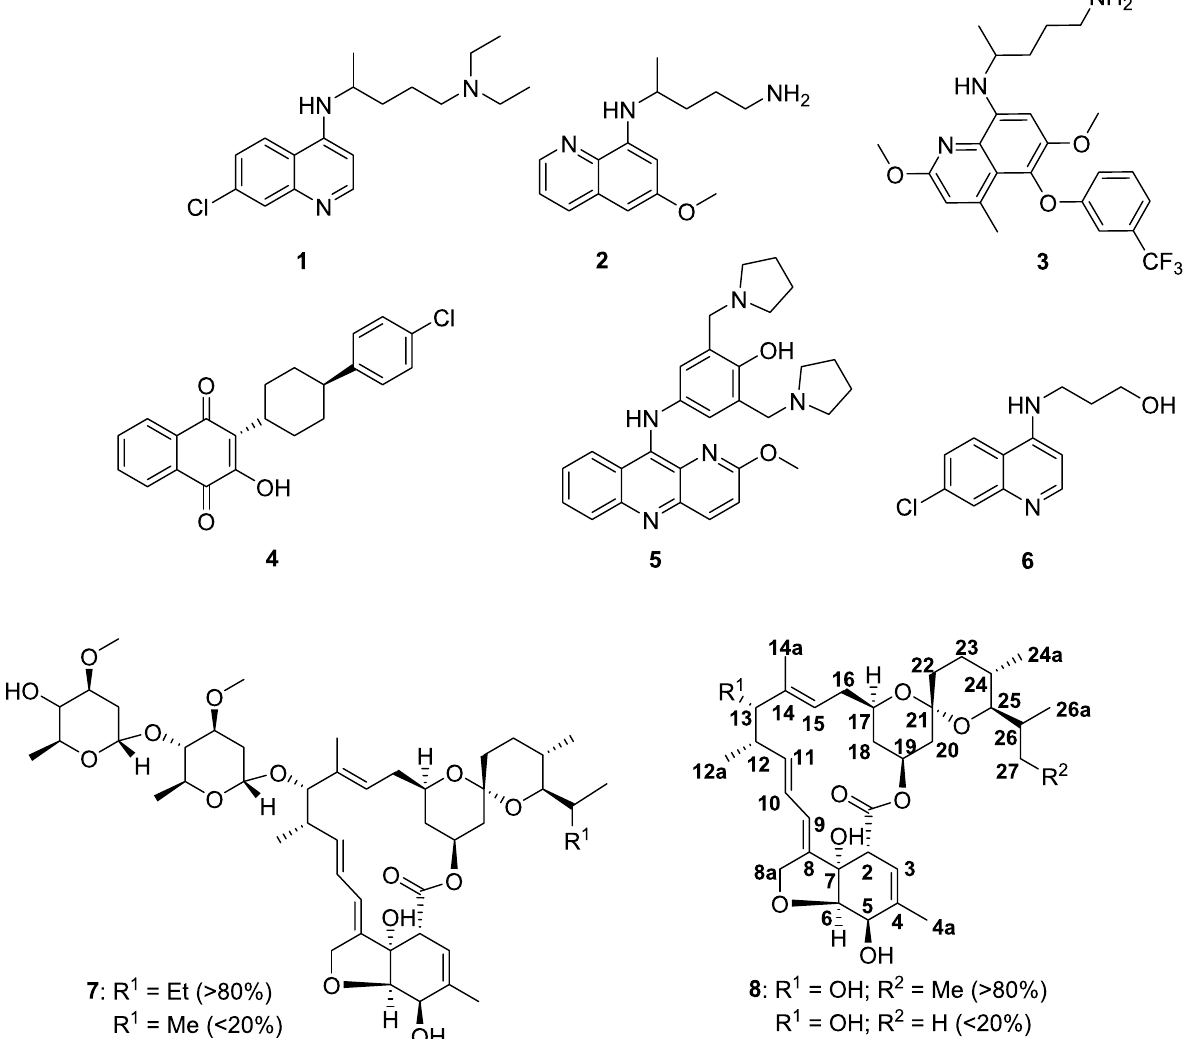
Figure 1. Structures of chloroquine 1 , primaquine 2 , tafenoquine 3 , atovaquone 4 , pyronaridine 5 , chloroquine analogue 6 , IVM 7 , IVM aglycon 8 and numbering